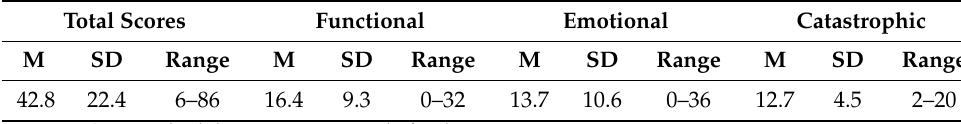
Table 2. Descriptive statistics of THI scores in the tinnitus group.